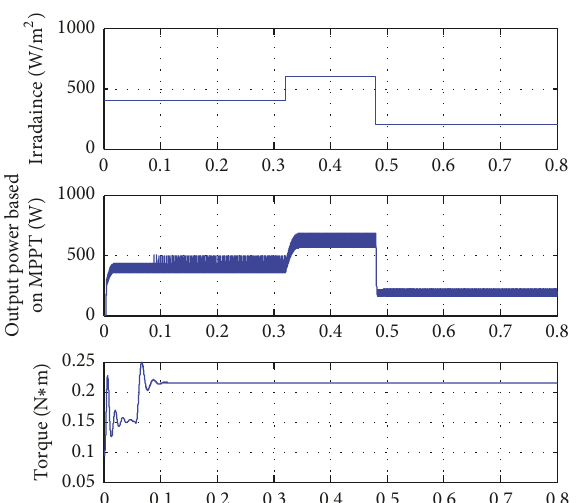
Figure 20: Solar water pumping system with battery storage system.